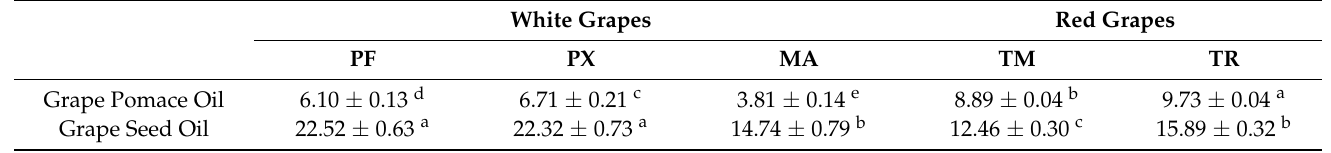
Table 1. Oil yields of pomace oils and grape seed oils (g oil by 100 g of by-product). White Grapes Red Grapes PF PX MA TM TR Grape Pomace